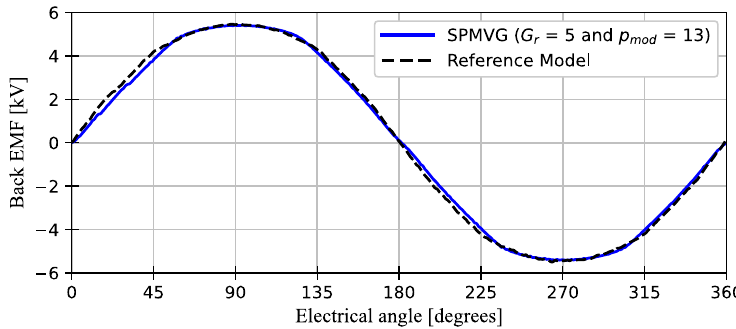
Figure 11. Comparison of back EMF waveforms (at ω rated = 7.56 rpm). Table 2. Performance Summary.